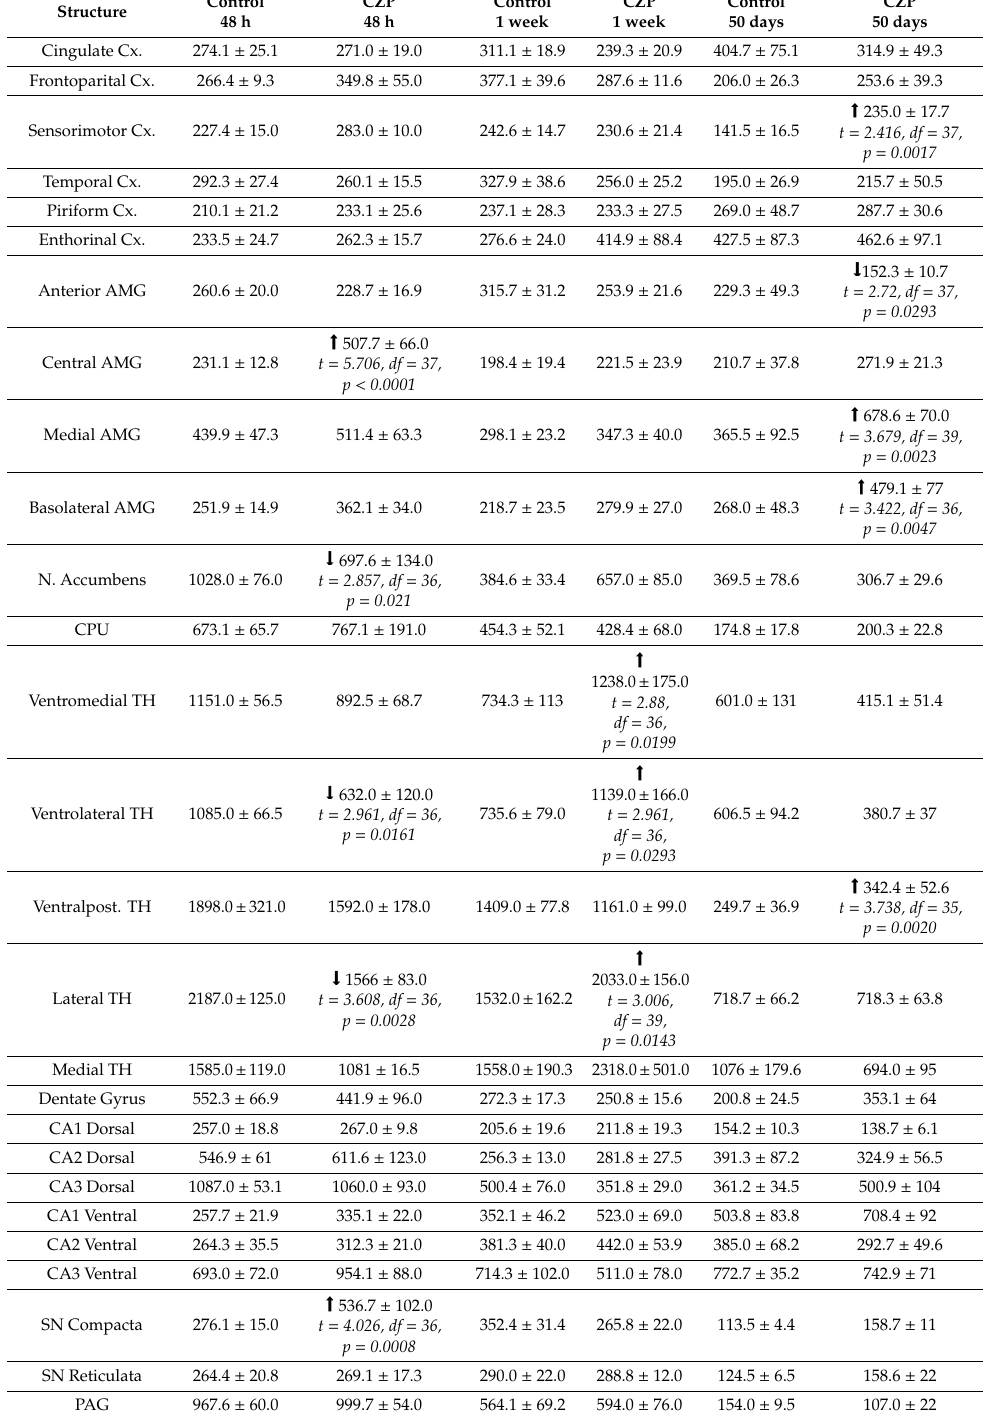
Table A4. [3H] CGP54626 binding to GABA B